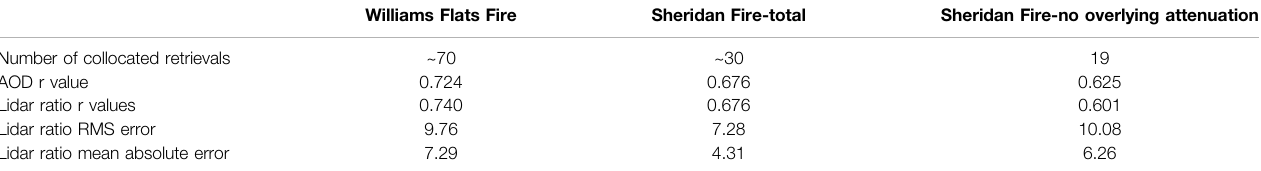
TABLE 5 | Summary statistics for collocated GOES MAGARA and CPL retrievals for the Williams fl ats and Sheridan fi